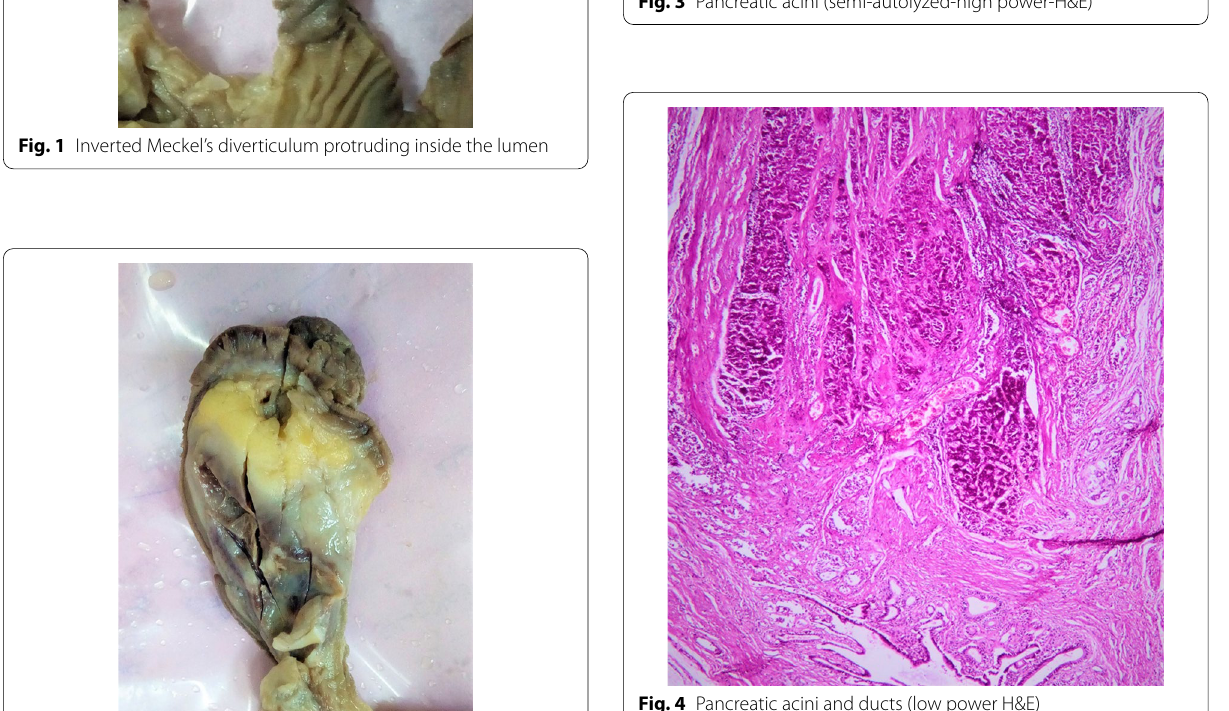
Fig. 4 Pancreatic acini and ducts (low power